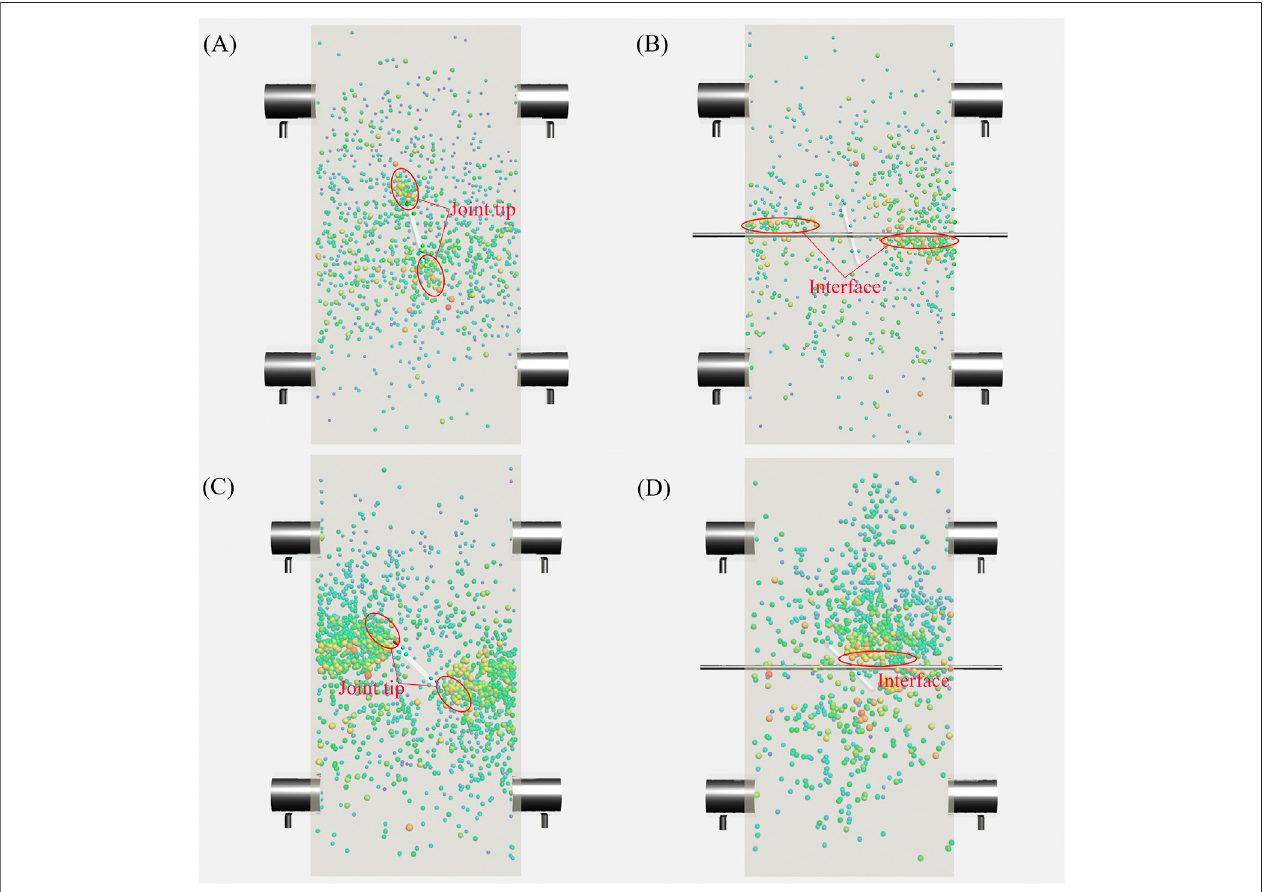
FIGURE12| Location ofAEeventsinjointedand boltedjointedspecimensunderuniaxialcompression: (A) 75 ° jointedspecimen, (B) 75 ° boltedjointedspecimen, (C) 45 ° jointed specimen, and (D) 45 ° bolted jointed specimen.